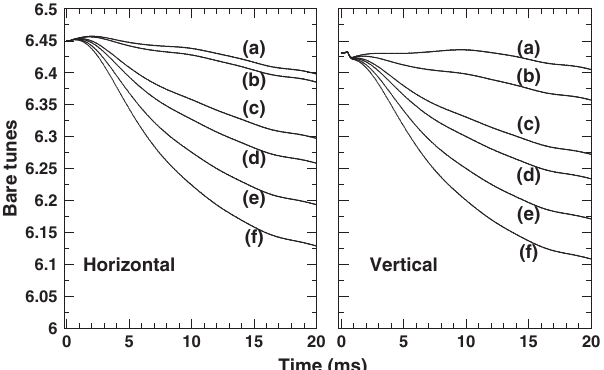
FIG. 28. Six sets of tune variations during acceleration applied for the beam instability measurement.